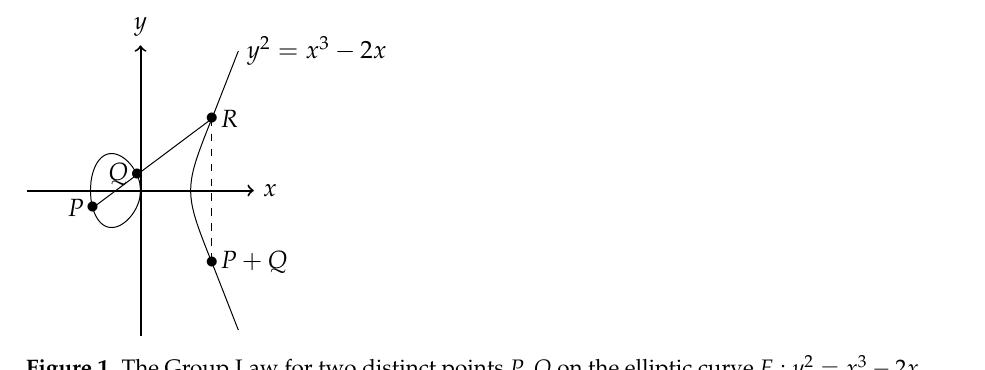
Figure 1. The Group Law for two distinct points P , Q on the elliptic curve E : y 2 = x 3